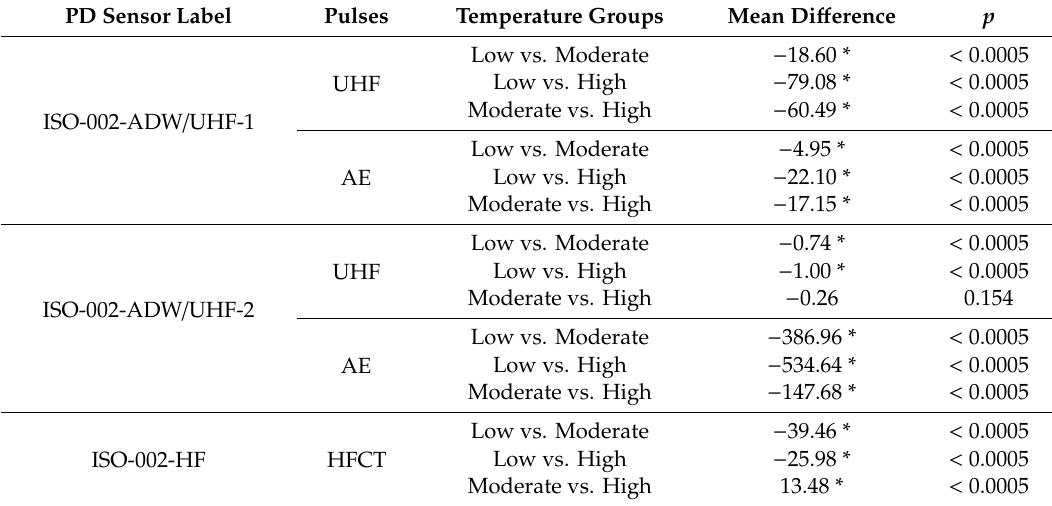
Results of multiple comparisons of mean PD pulses within groups using post hoc Games–Howell